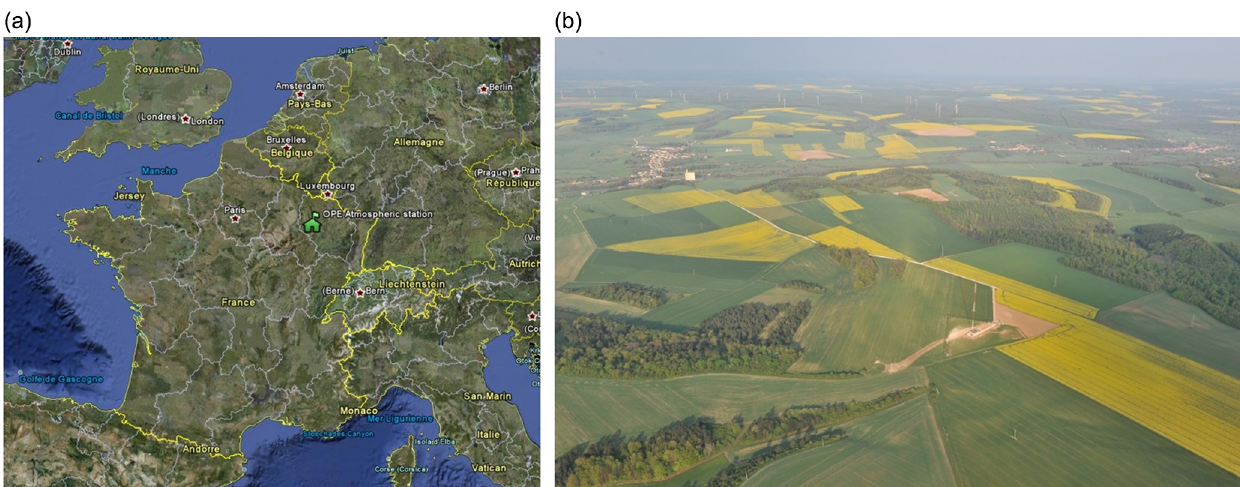
Figure 1. Geographical location of the OPE atmospheric station ( a , ©Google) and aerial photograph illustrating the landscape surrounding the station (b)